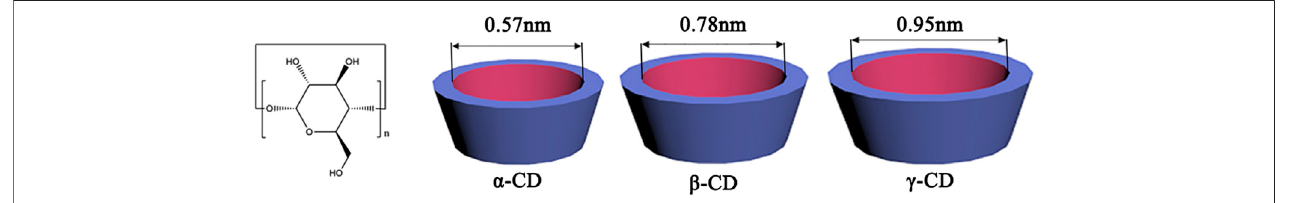
FIGURE 1 | The structures of α -CD (n (cid:1) 6), β -CD (n (cid:1) 7), and γ -CD (n (cid:1)